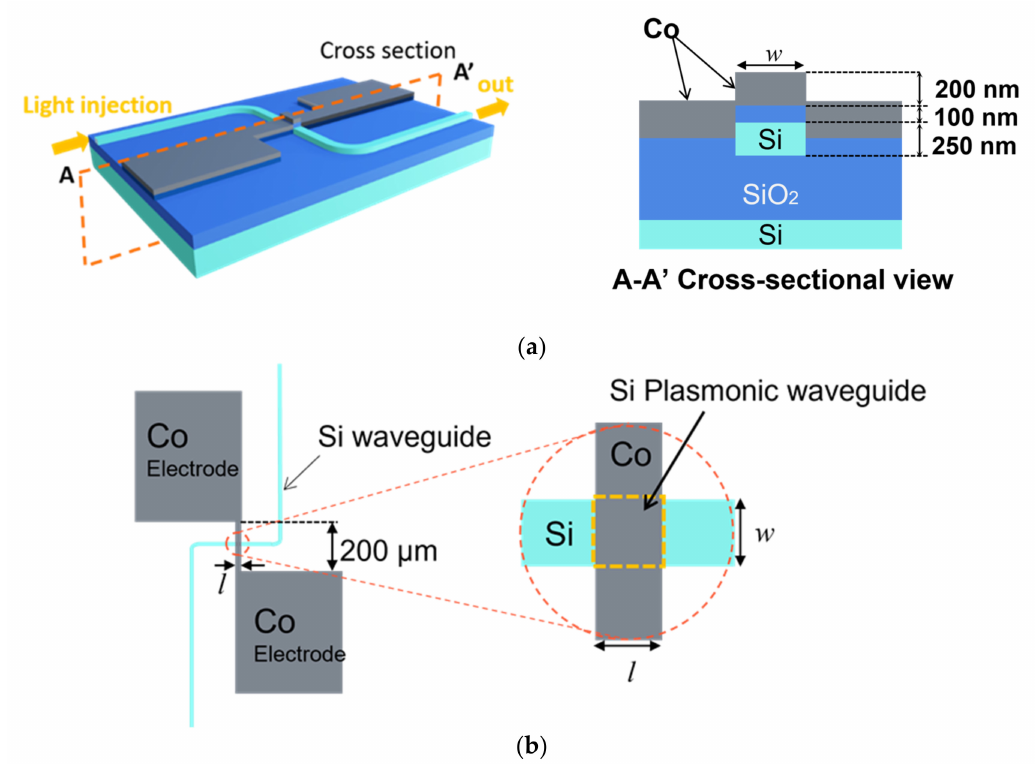
Figure 1. Schematic images of a Si plasmonic waveguide heater with the width of w , and length of l . ( a ) Entire image and cross-sectional image of the Si plasmonic waveguide with optical input waveguide and a pair of electrodes. ( b ) Dimension of the Si plasmonic waveguide heater loaded with a Co thin film, connected to a pair of electrode